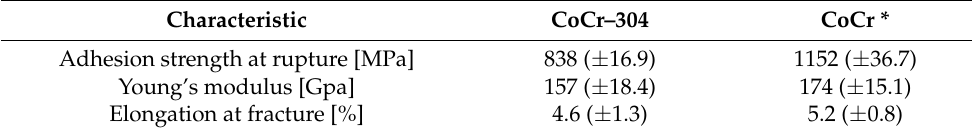
Figure 6. Mechanical response of SLM-fabricated CoCr – 304 and CoCr specimens; Comparison with literature results (References) for wrought 304 SS [38 – 40] and SLM-fabricated CoCr [22,36,37,41]. Table 4. Adhesion strength between CoCr and 304 SS (mean ± standard deviation).